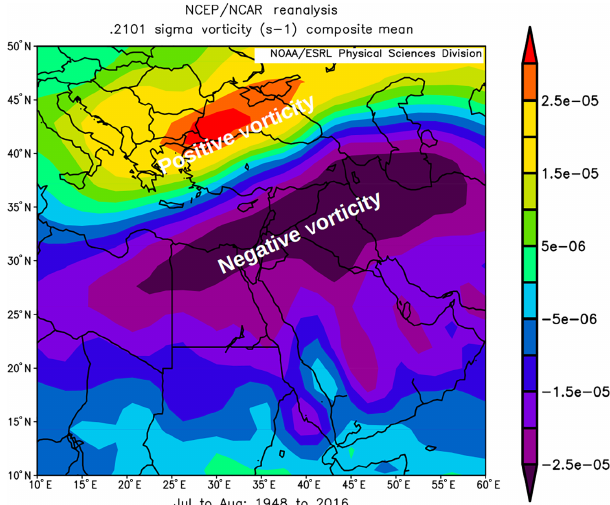
Figure 4. NCEP/NCAR reanalysis long-term averages (1948– 2016) of the relative vorticity at 200hPa ( ∼ 12kma . s . l . ) for July– August. The relative vorticity vector is generally perpendicular to the ground, positive when the vector points upward, and nega- tive when it points downward. Note the negative relative vortic- ity region located over the southeastern Mediterranean as a re- sult from both shear and curvature negative relative vorticity. Rel- ative vorticity units are 10 − 5 s − 1 . NCEP reanalysis data are pro- vided by the NOAA/OAR/ESRL PSD, Boulder, Colorado, USA; http://www.esrl.noaa.gov/psd/.